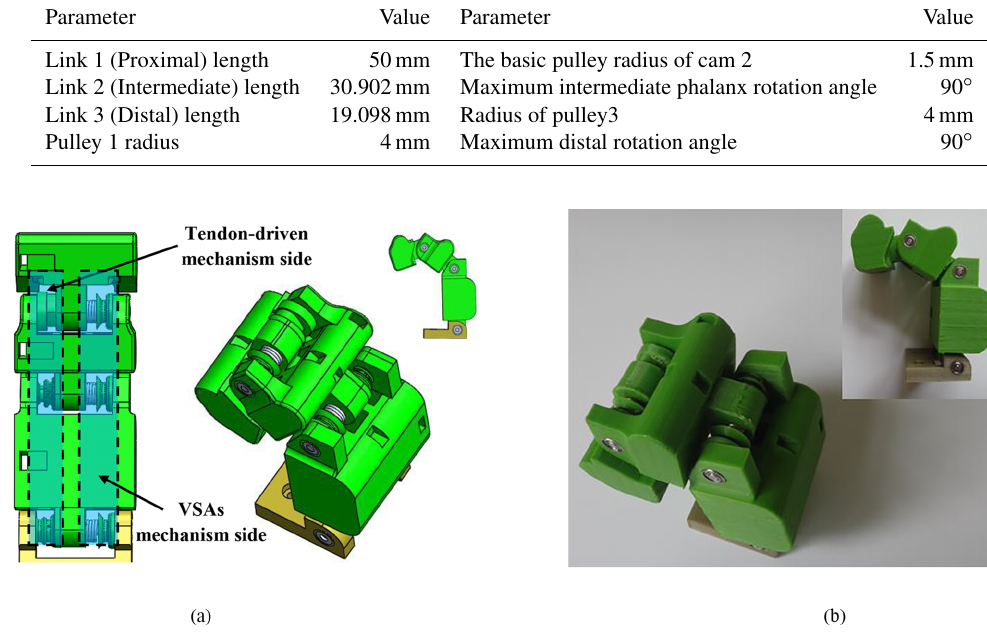
Figure 8. CPRF mechanical parts (a) CAD drawing (b) produced